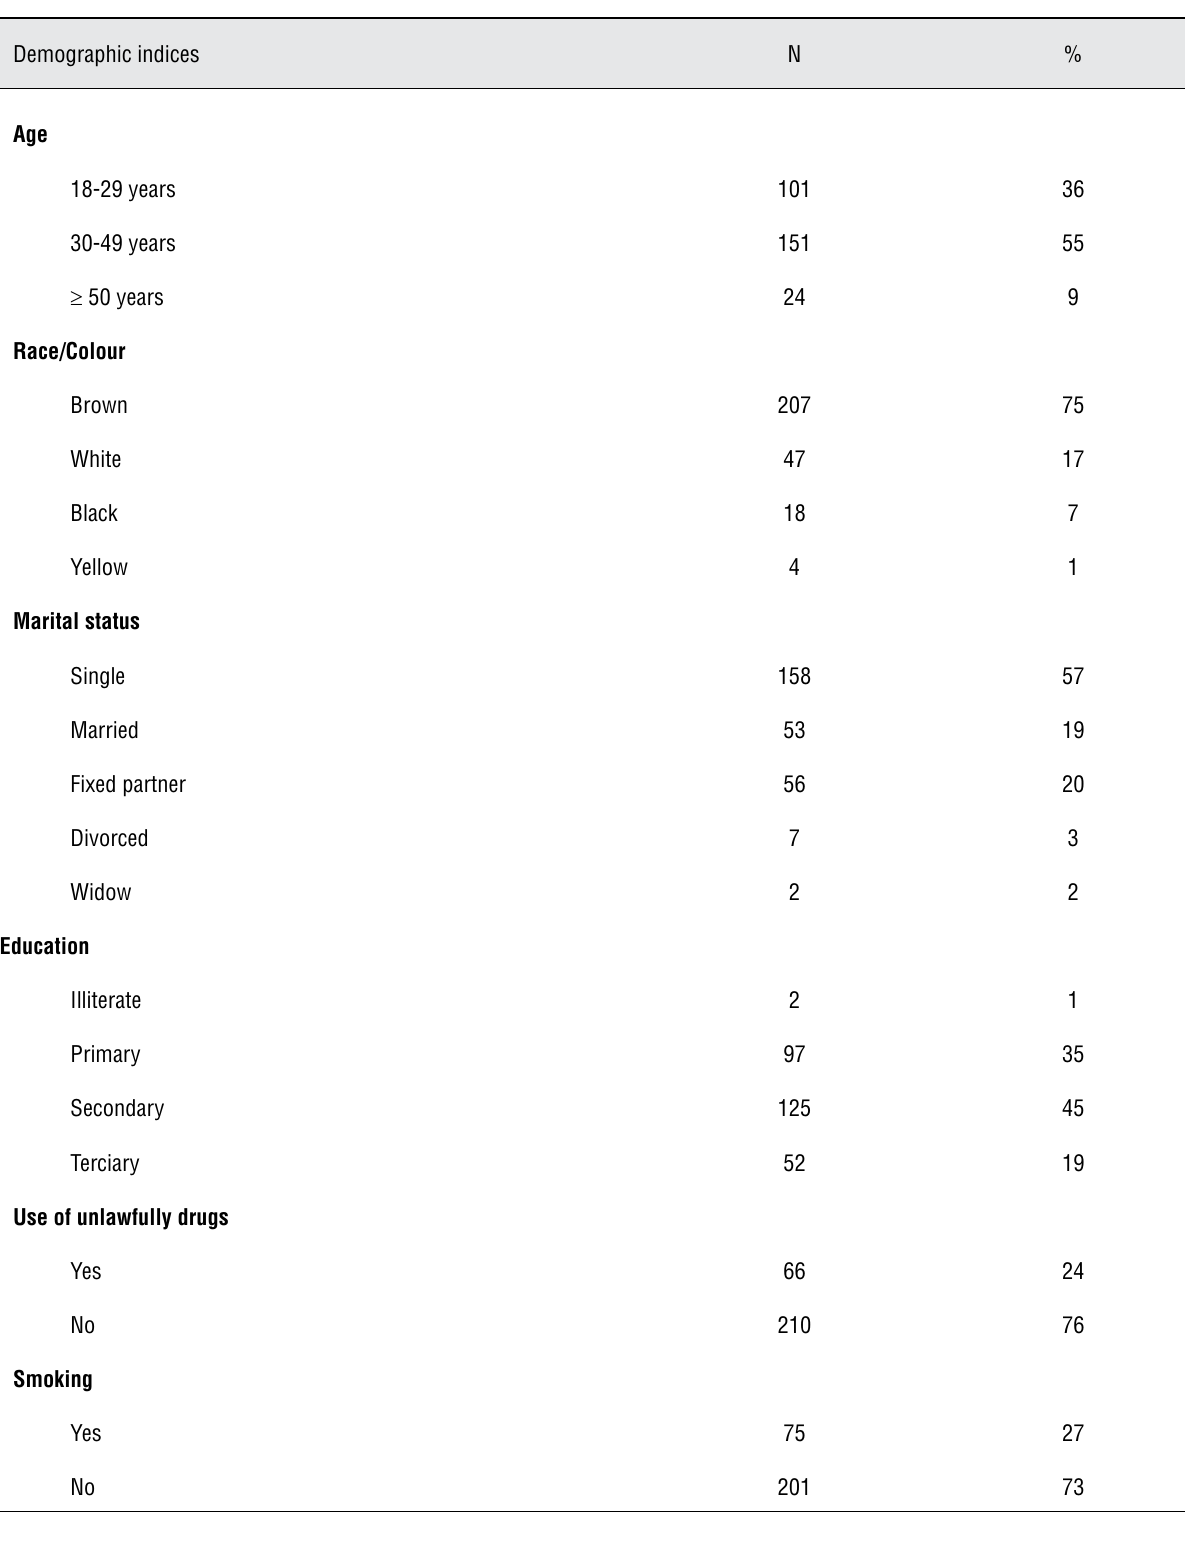
Table 1 - Socio-demographic variables of 276 men with